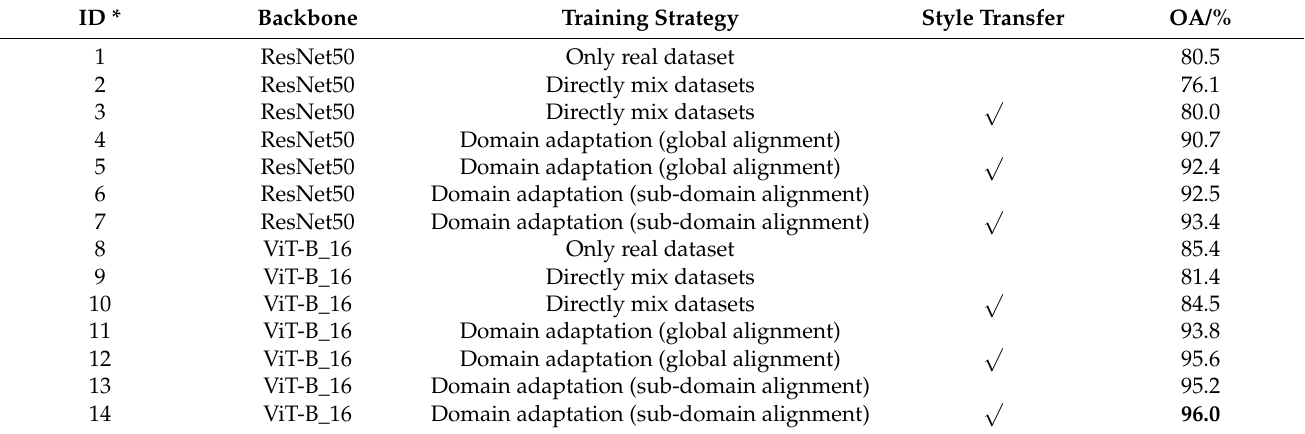
Table 3. Test results on ship fine-grained